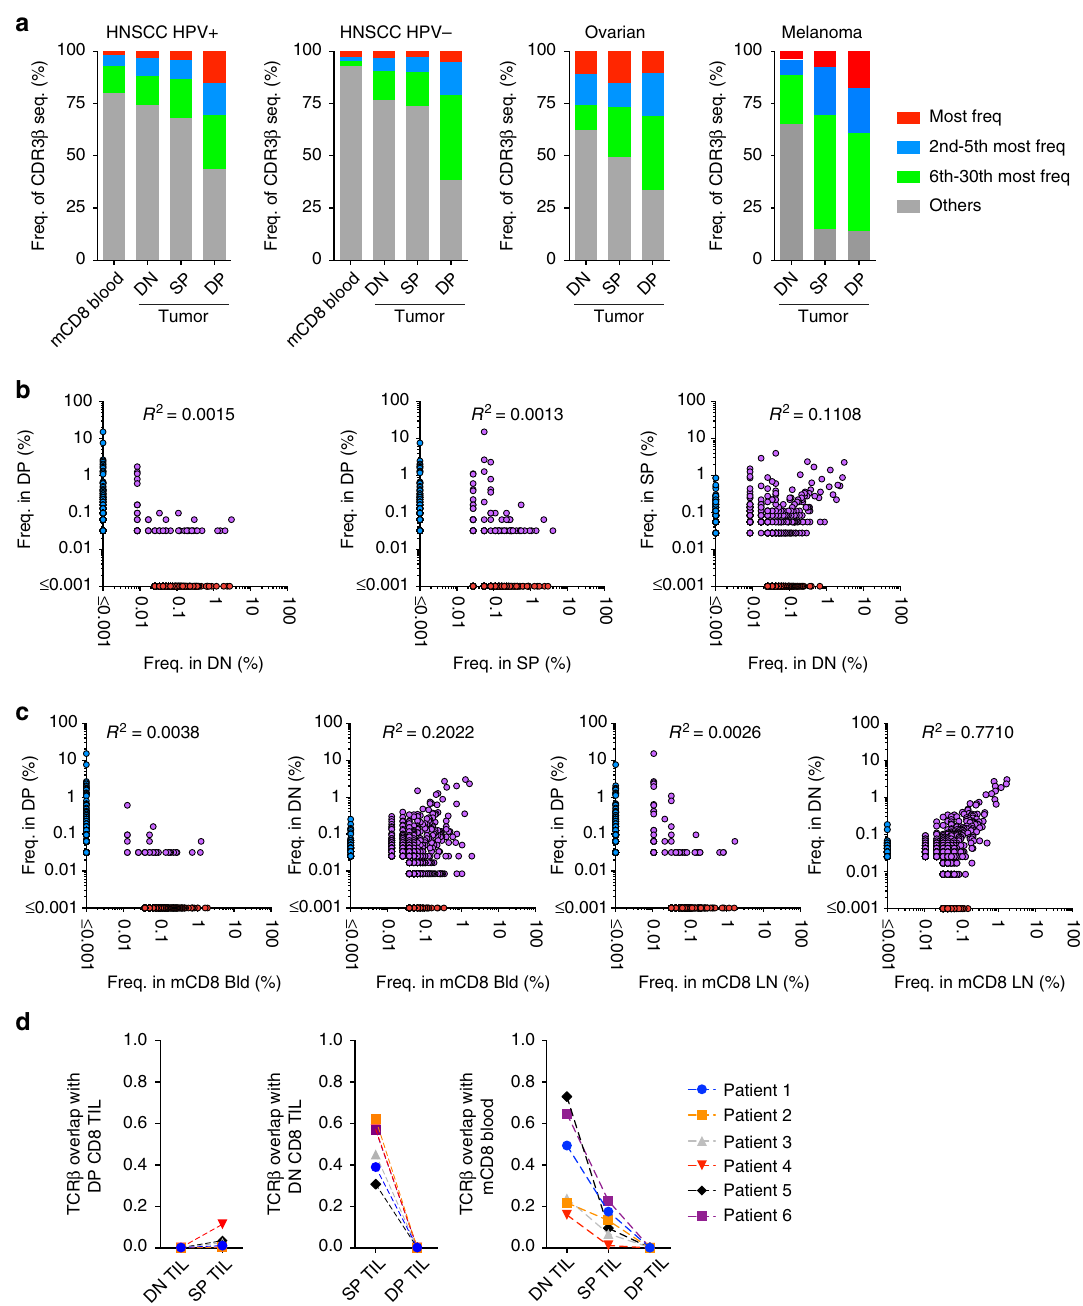
Fig. 5 DP CD8 T cells are highly clonal and share little overlap with other CD8 TILs or peripheral CD8 T cells. a Diversity of the TCR β repertoire within blood memory CD8 T cells, DN, SP, and DP CD8 TILs. The frequencies of the most frequent clonotype, the 2nd to 5th most frequent, the 6th to 30th most frequent, and the rest of the clonotypes (others) are shown for a HPV-positive HNSCC patient, a HPV-negative HNSCC patient, an ovarian cancer patient, and a melanoma patient. b The 500 most frequent CD8 TIL clonotypes for each subset are plotted based on their frequency in DN, SP, and DP CD8 TILs. Each dot represents a distinct TCR clonotype. Dots on the axis indicate the clonotypes detected within a single repertoire; purple dots indicate clonotypes shared between two CD8 T-cell populations. c Same analysis as in b comparing the frequency of the top 500 clones in memory CD8 T cells in peripheral blood and uninvolved LN to the frequency in DN and DP CD8 TIL subsets. d Similarity between the TCR repertoires of CD8 T-cell subsets was measured using the Morisita – Horn index on six cancer patients connected with a dashed